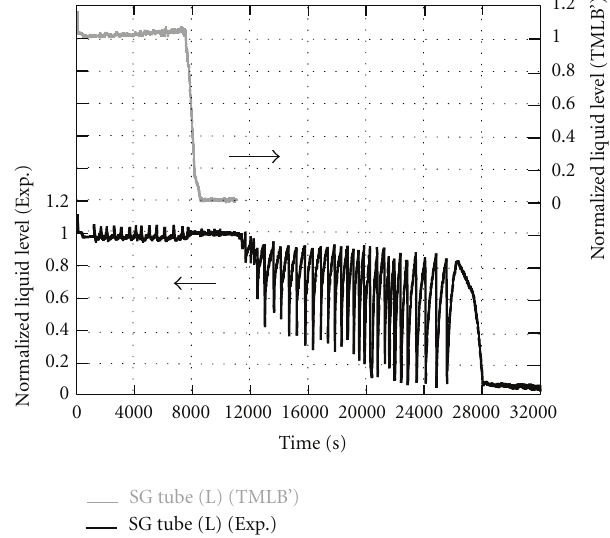
Figure 26: Comparison with TMLB’ scenario test results for collapsed liquid level in upflow side of SG Tube 3 in loop with PZR.